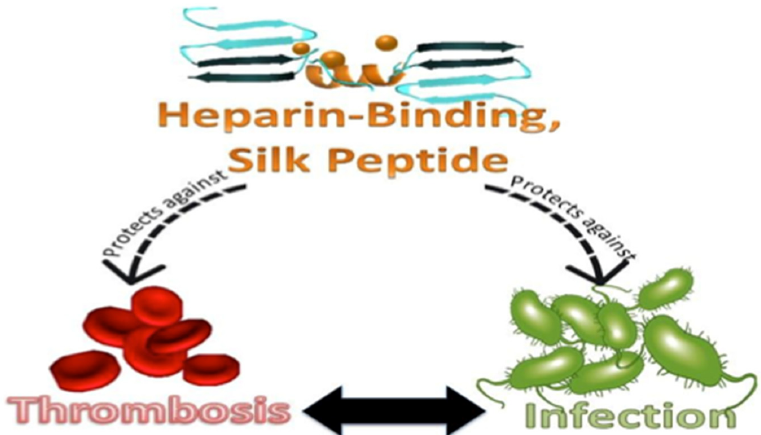
Figure 1. Infection and thrombosis are intimately connected. This is of particular concern for hemodialysis catheters and other blood-contacting medical devices. Using the naturally occurring heparin-binding motif (HBM) with the silk peptide can both bind heparin to alter coagulation and pro- vide antimicrobial properties, ultimately improving blood compatibility and limiting infection risks. Heparin, a hydrophilic, highly sulfonated, negatively charged polysaccharide copoly- mer comprised of glucosamine and glucuronic acid, is endogenously found in the human body (approximately 20 µg/mL in adult plasma). It is also commonly used as an ex- tracorporeal anticoagulant at therapeutic concentrations over 50 nM [18,19]. Importantly, heparin is naturally bound to a diverse family of heparin-binding proteins based largely